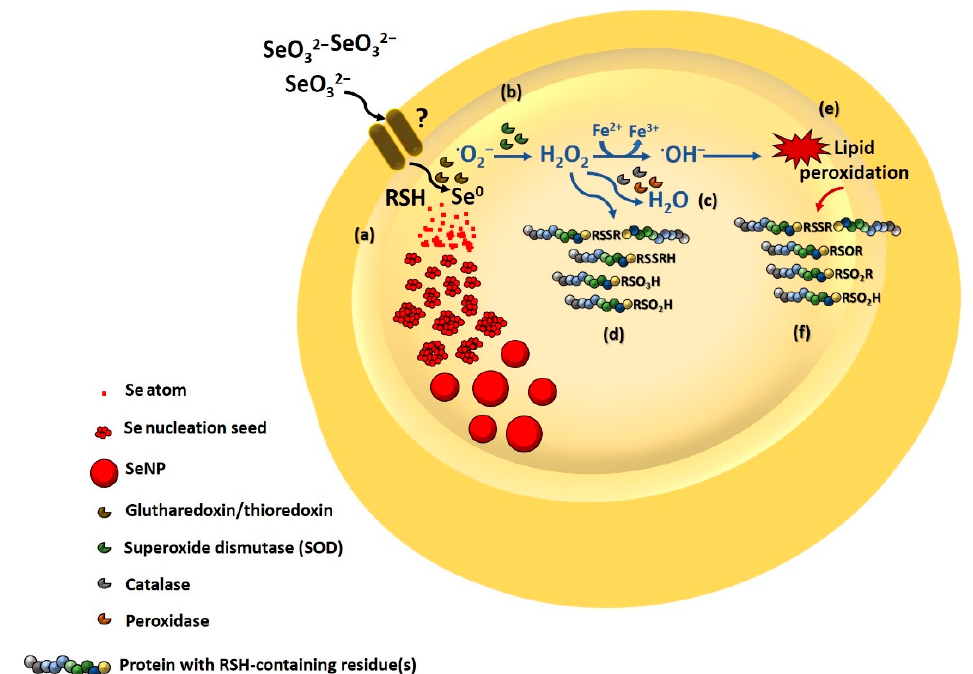
Figure 4. SeO 32 − is bioconverted into Se 0 and · O 2 − likely through Painter-type reaction involving intracellular RSH-containing molecules and enzymes with a high affinity for the RSSeSR intermediate, such as glutharedoxin and/or thioredoxin. This bioprocess causes a build-up of ( a ) Se atoms in the intracellular environment, which eventually aggregate with each other, and ( b ) · O 2 − that are generally converted by superoxide dismutase (SOD) into H 2 O 2 . Once a certain solubility threshold of Se atoms is reached, Se-nucleation seeds are produced and aggregate forming SeNPs to counteract their thermodynamic instability, while ( c ) H 2 O 2 is usually transformed by catalases and/or peroxidases into H 2 O. However, an excess of this ROS can lead to ( d ) modifications in RSH-containing proteins (i.e., disulfide bridges, S-thiolation, and overoxidation of cysteine residues to sulfinic and sulfonic acids) and ( e ) the peroxidation of polyunsaturated fatty acids of the bacterial membrane. The latter, in turn, can give rise to ( f ) further modifications of RSH-containing proteins and/or molecules, such as the generation of disulfide bridges, sulfinic acids, and cysteine mono- and di-oxide residues. Overall, RSH-containing molecules and their derivatives were abundantly detected for bacterial cells exposed to SeO 32 − and the two biogenic SeNP extracts, while only a few IR signals typical of these functional groups were observed for the other samples, including the recovered OM (Tables S3–S10). Since most of the RSH modifications caused by SeO 3 2